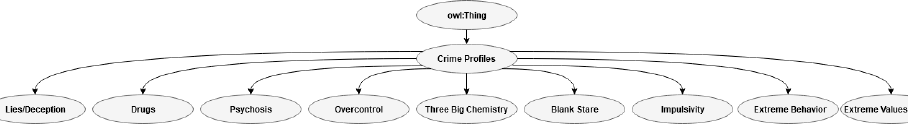
Figure 7. Class crime